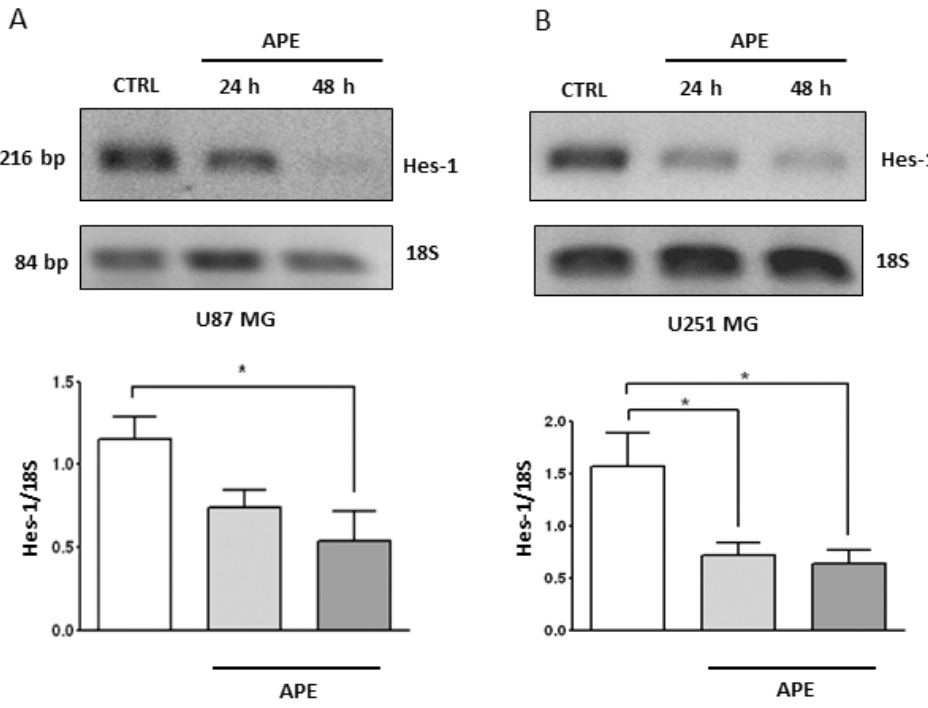
Figure 5. Hes-1 Expression in GBM cell lines. RT-PCR analysis of Hes-1 in U87MG ( A ) and U251MG ( B ) cells treated with 100 µ M APE for 24 and 48 h. The graphs show the densitometric analysis of the bands normalized for the housekeeping 18S. The OD is the mean ± SEM of three independent experiments. (* p < 0.05; One-way ANOVA test).